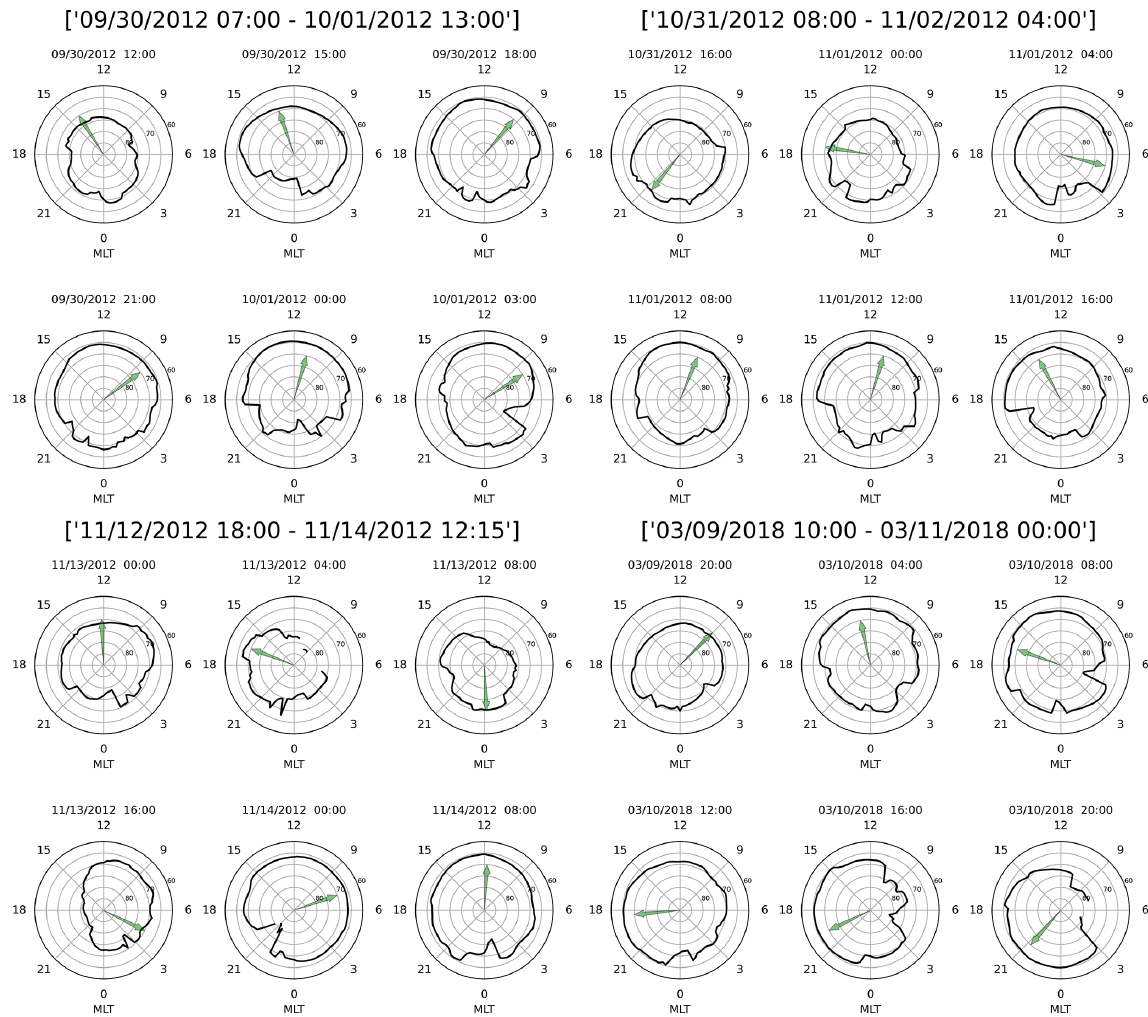
Figure 7. Four groups of polar plots corresponding to the clock angle and OCB latitude plots of Fig. 6. Within each of the groups, the six polar views show the location of the OCB as a solid black line. The green arrows show the direction of the IMF vector as viewed towards the Sun. It is evident that the maximum equatorward extent of the polar cap follows the clock angle direction of the